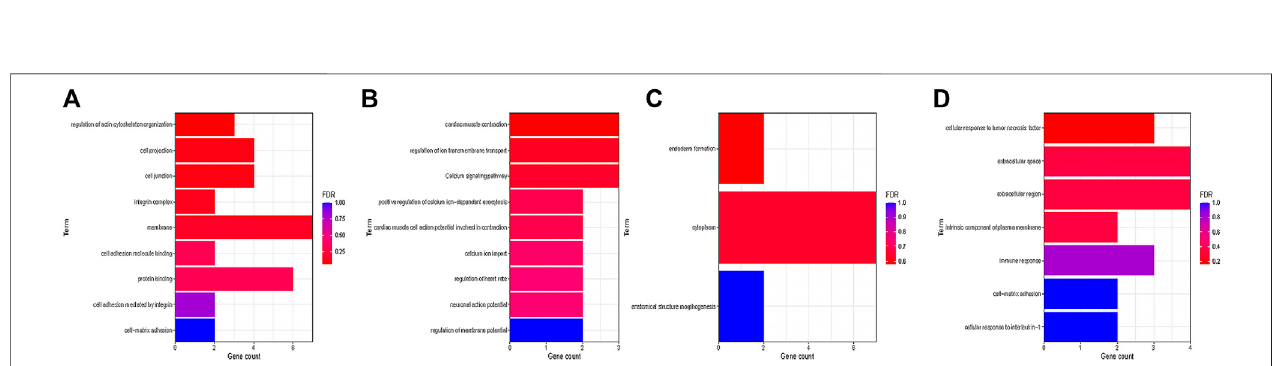
FIGURE6| GOanalysisofsmoothmusclecellsubtypes. (A) GOenrichmentanalysisofSMC2. (B) GOenrichmentanalysisofSMC6. (C) GOenrichmentanalysisof SMC7. (D) GO enrichment analysis of SMC5.